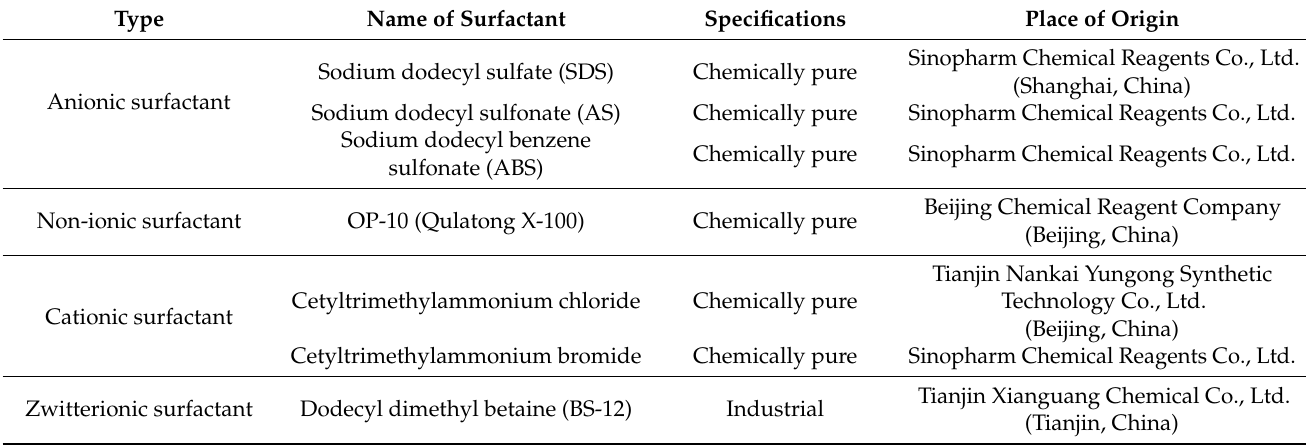
Table 1. Surfactants of Experimental Choice.